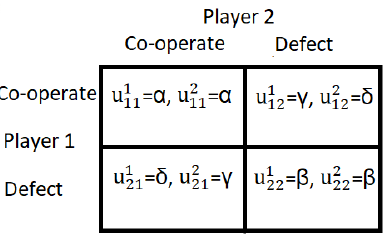
Figure 1. Payoff matrix of the two-player prisoner’s dilemma game where δ > α > β > γ